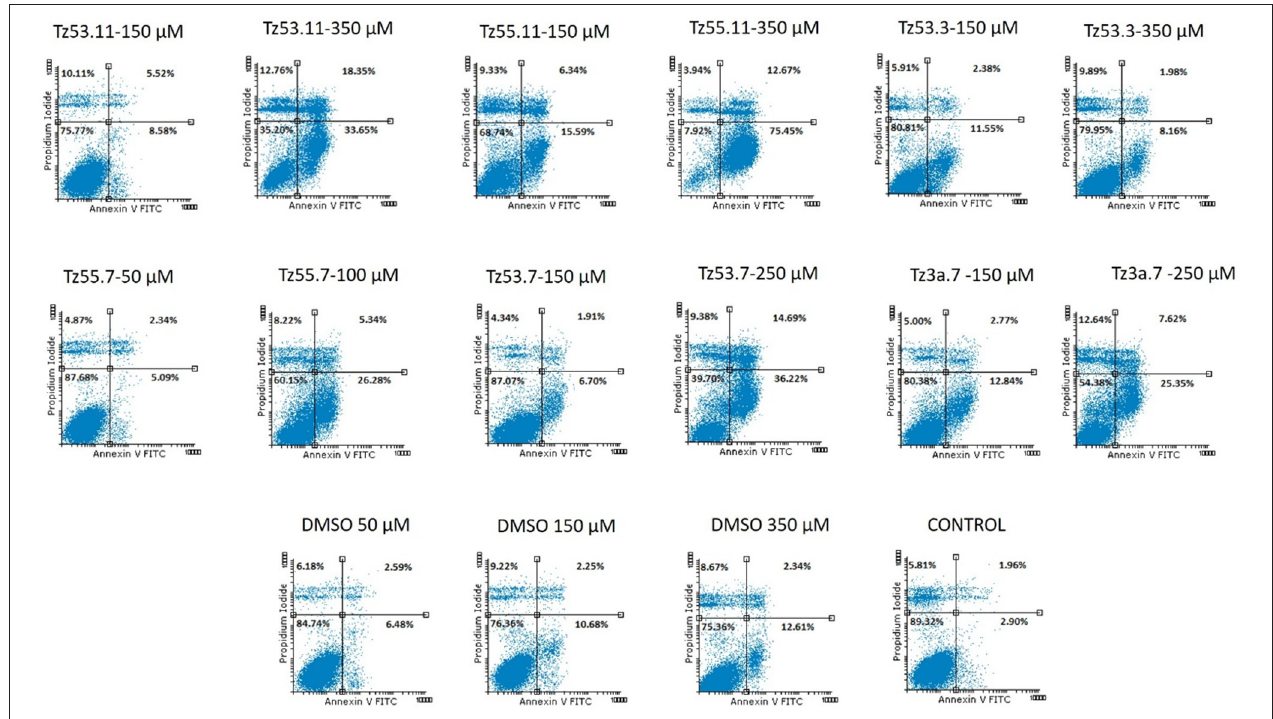
FIGURE 9 | Representative dotplots for the flow cytometric analysis of HT-29 cell apoptosis.